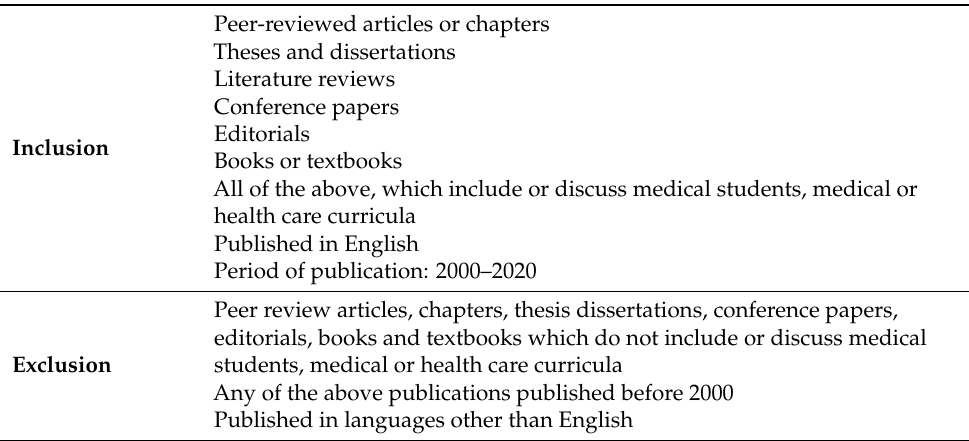
Table 1. Inclusion and exclusion criteria.